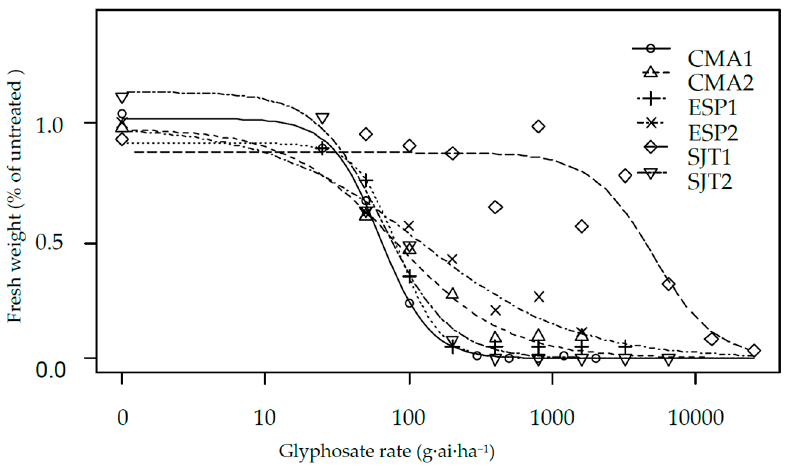
Figure 2. Weight response of six biotypes of Amaranthus hybridus to dicamba. Agronomy 2018 , 8 , x